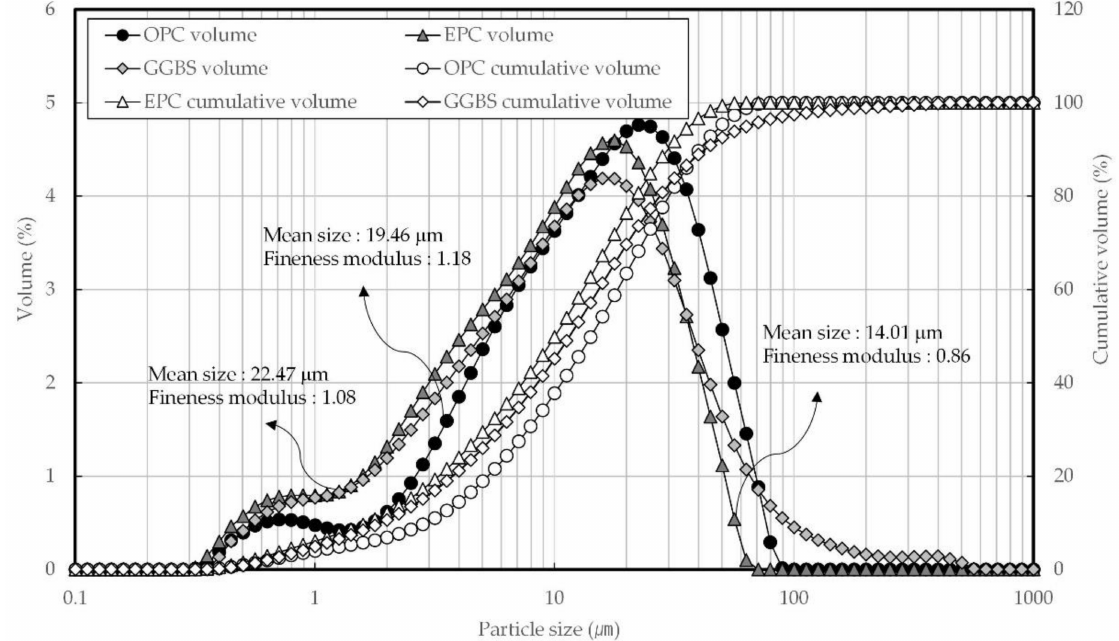
Figure 3. The particle size distribution of OPC (ordinary Portland cement), EPC (early Portland cement), and GGBS (ground granulated blast-furnace